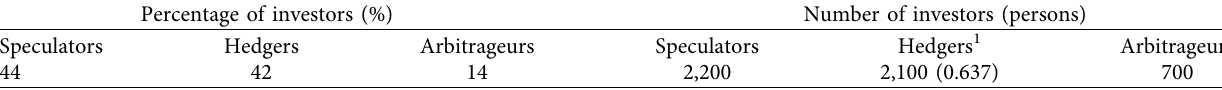
Table 8: Design of the investor structure of the stock index futures model.